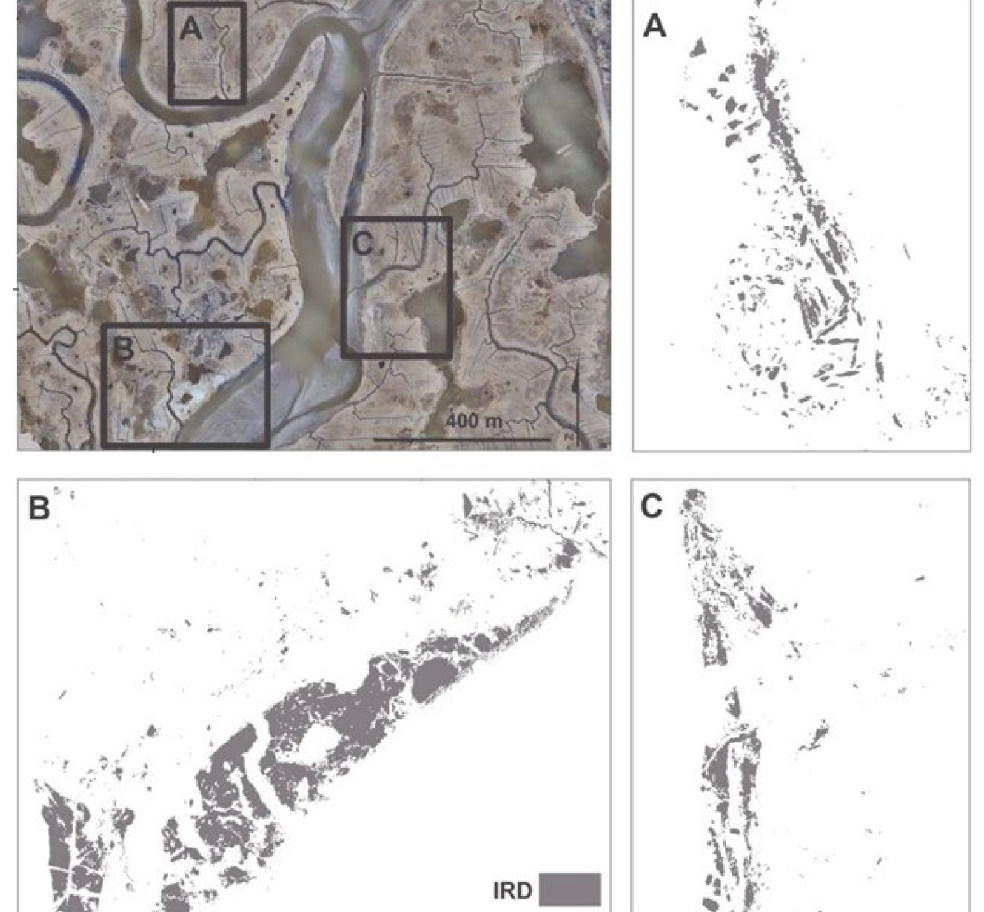
Figure 5. Classification of the 2018 ortho ‐ imagery. ( A – C ) are the classified IRD deposits located in the three rectangular areas reported in the ortho ‐ image.